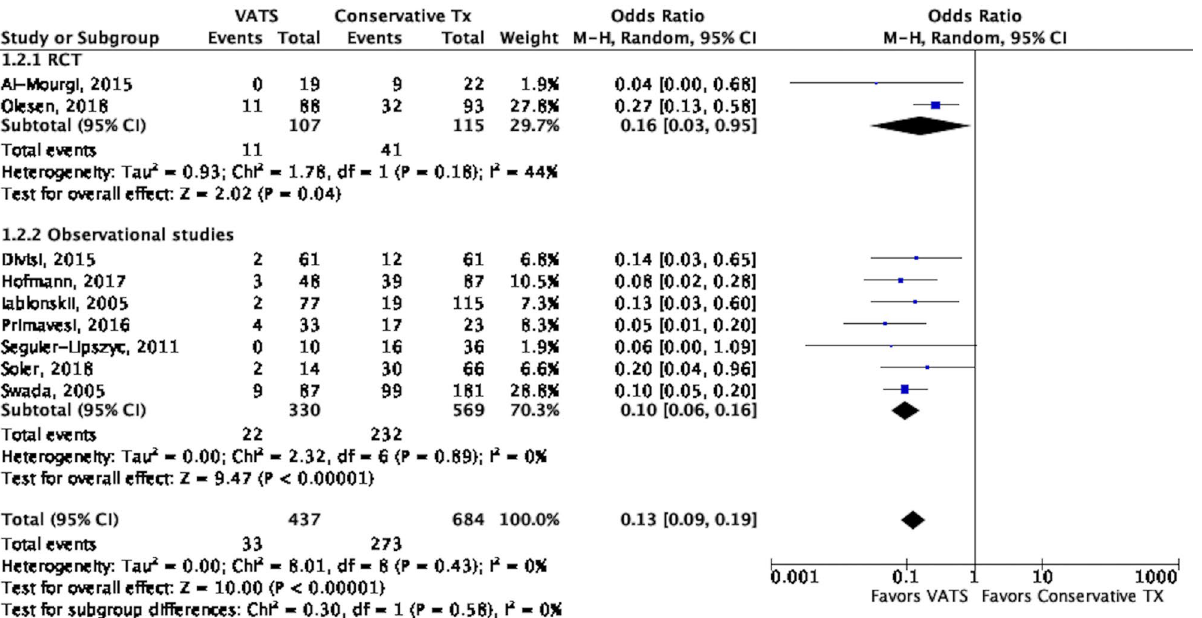
Figure 2. Forest plot of the comparison of recurrence rate between VATS and conservative treatment.